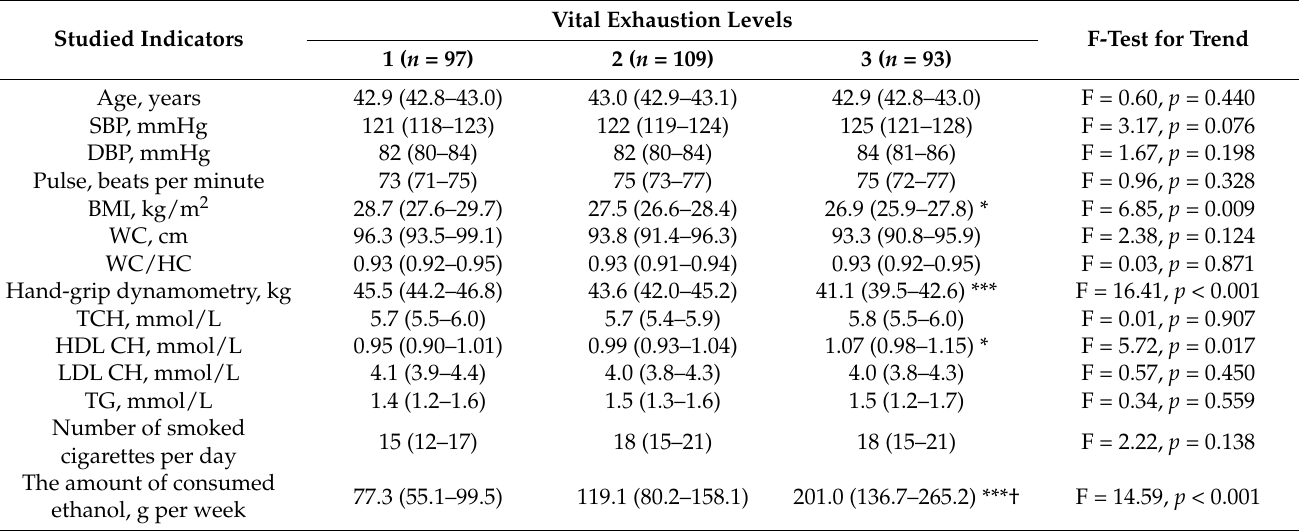
Table 2. Comparative analysis of CVD risk markers in groups of males with different vital exhaustion